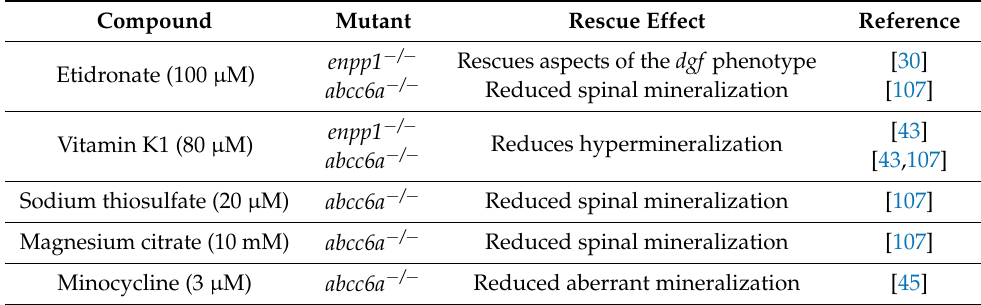
Table 3. Compounds to rescue ectopic mineralization in